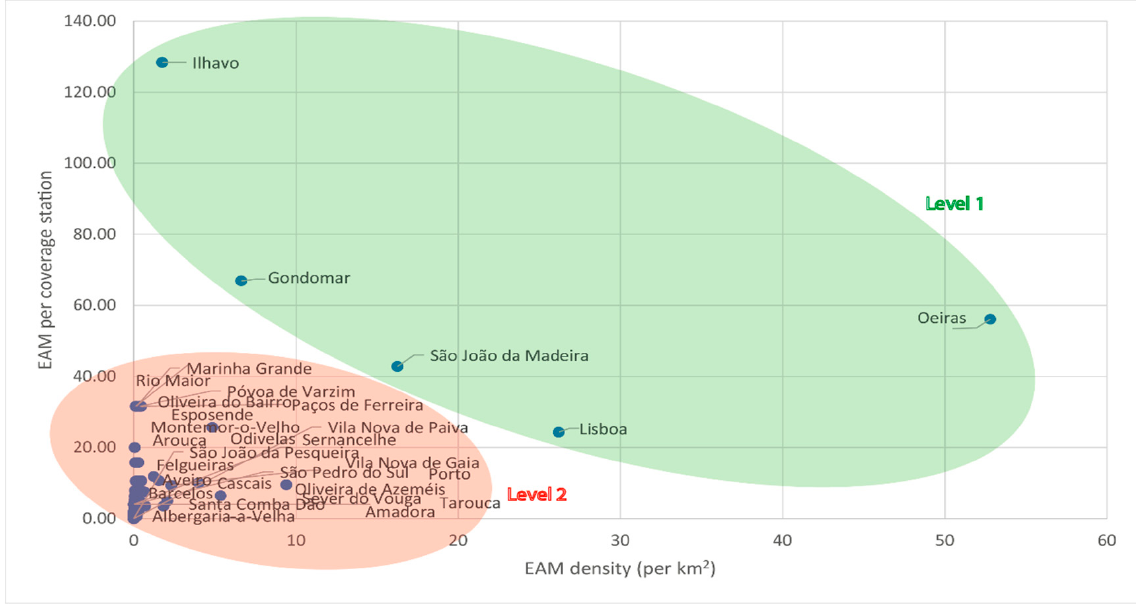
Figure 15. Cities with greater propensity according to the SERA model.